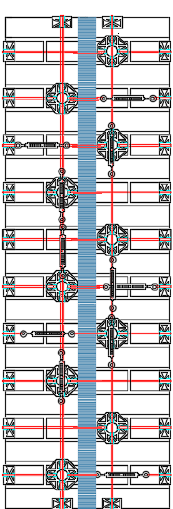
Figure 13. Layout scheme of the straps for the second combined technique.